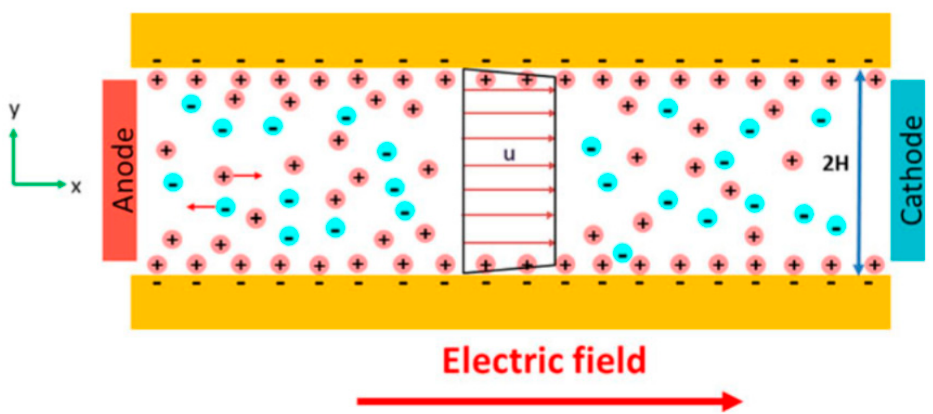
Figure 10. Schematic of conventional electroosmosis in a microchannel. Reprinted with permission from [190]. Copyright 2017, John Wiley and Sons.